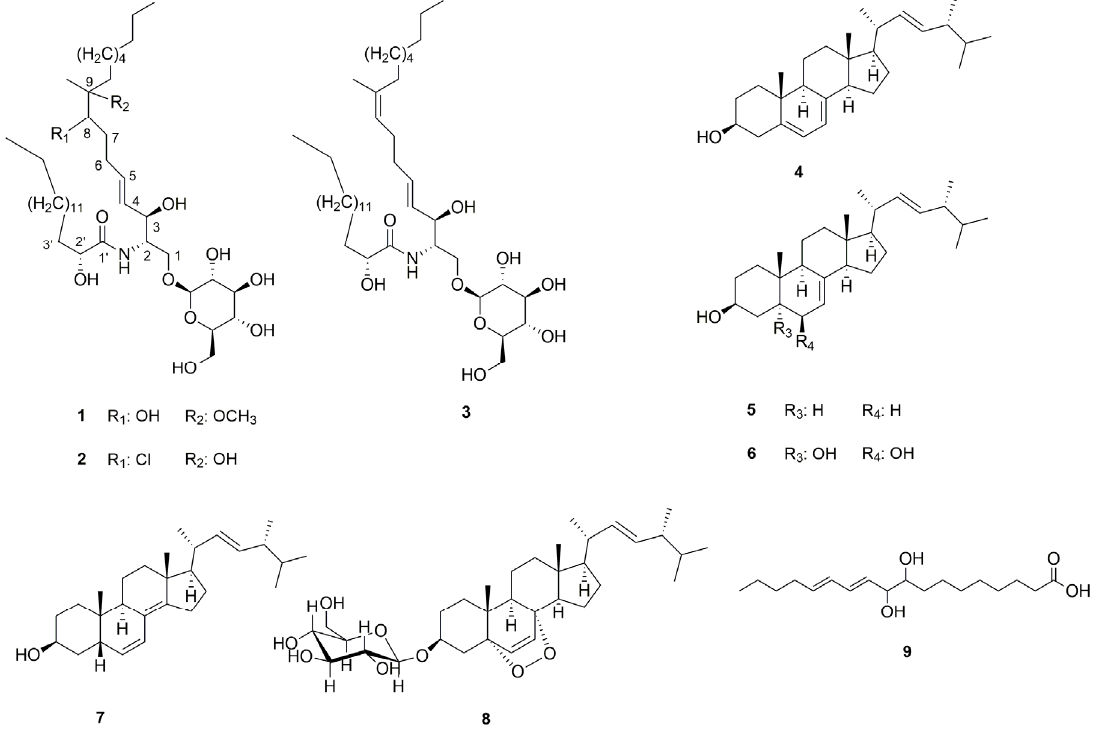
Figure 1. Compounds isolated from M. giganteus (stereodescriptors indicate only relative stereochemistry).